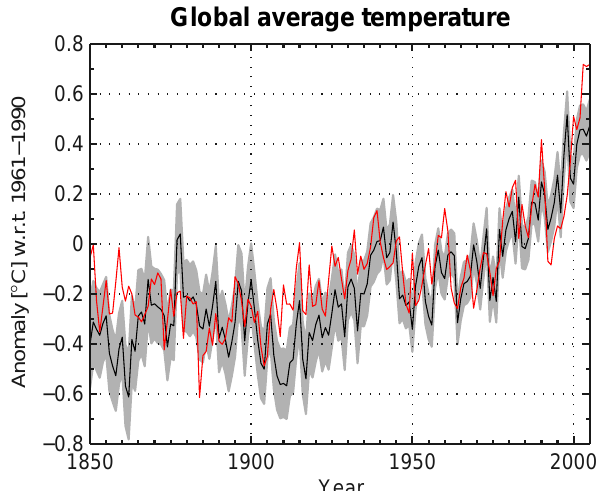
Fig. 1. Time series of model simulated global mean surface tem- perature anomaly with respect to the 1961–1990 period (red line). Plotted together is the observational estimate from the HadCRUT3 product (black line) with the respective uncertainty range in grey shades (Brohan et al., 2006).